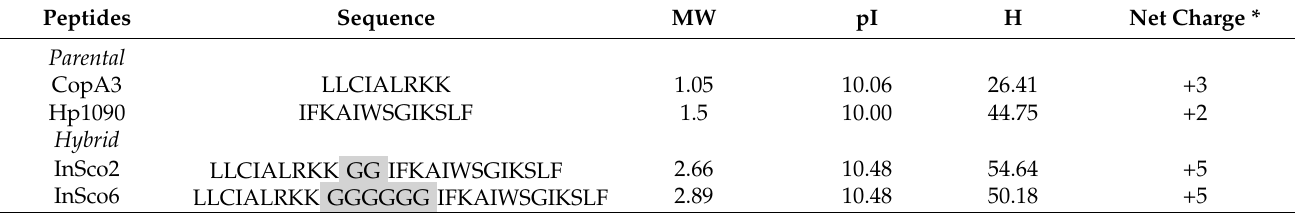
Table 1. Sequence information of the parental and hybrid AMPs and predicted physicochemical properties.